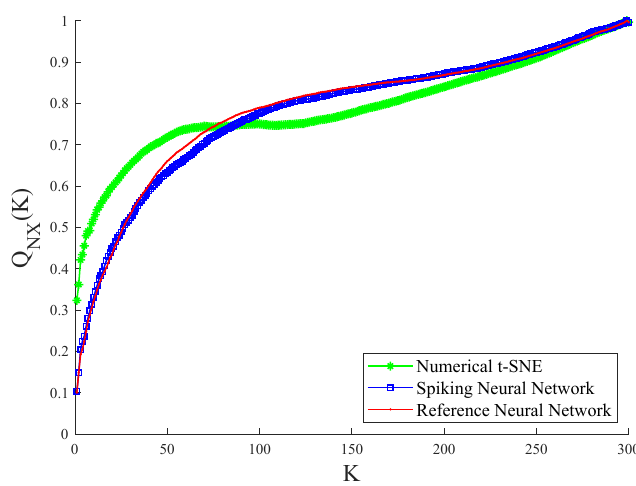
Figure 12. The graphs of the co-ranking